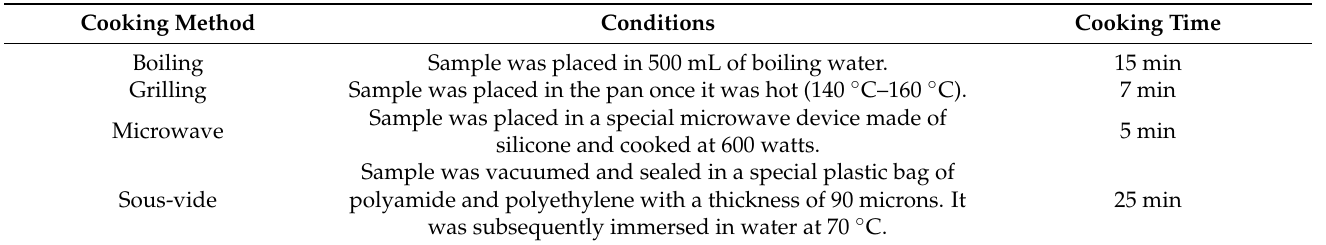
Table 1. Specific conditions for each cooking